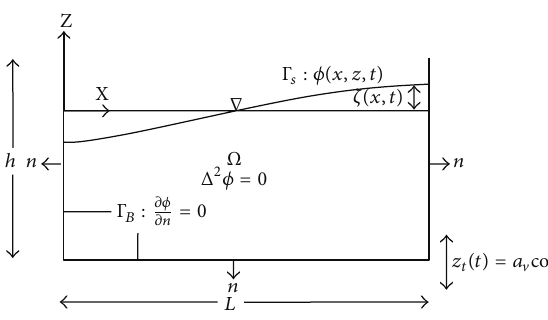
Figure 1: Sloshing tank and its boundary